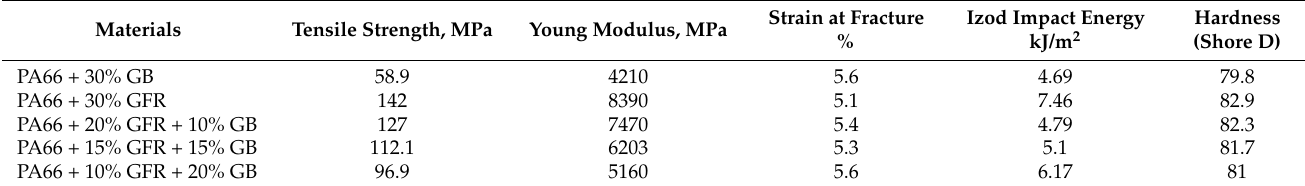
Table 2. Mechanical properties of GB/GF-reinforced PA66 matrix